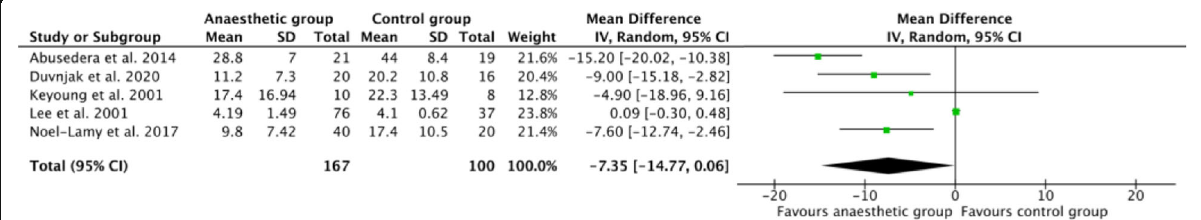
Fig. 3 A forest plot of randomised controlled trials (RCTs) summarising the effect of intra-arterial anaesthetic on